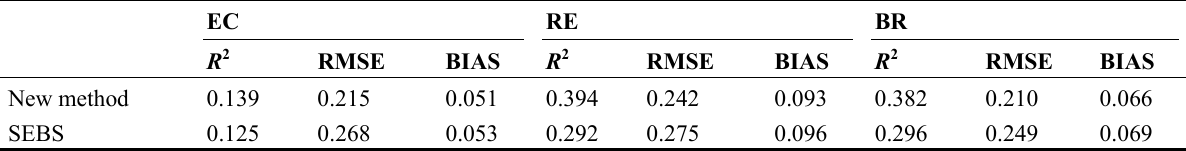
Table 4. Comparisons of the remotely sensed daily EF estimated by our proposed method and the SEBS model with EC-measured, RE and BR-corrected EF. EC RE BR R 2 RMSE BIAS R 2 RMSE BIAS R 2 RMSE BIAS New method 0.139 0.215 0.051 0.394 0.242 0.093 0.382 0.210 0.066 SEBS 0.125 0.268 0.053 0.292 0.275 0.096 0.296 0.249